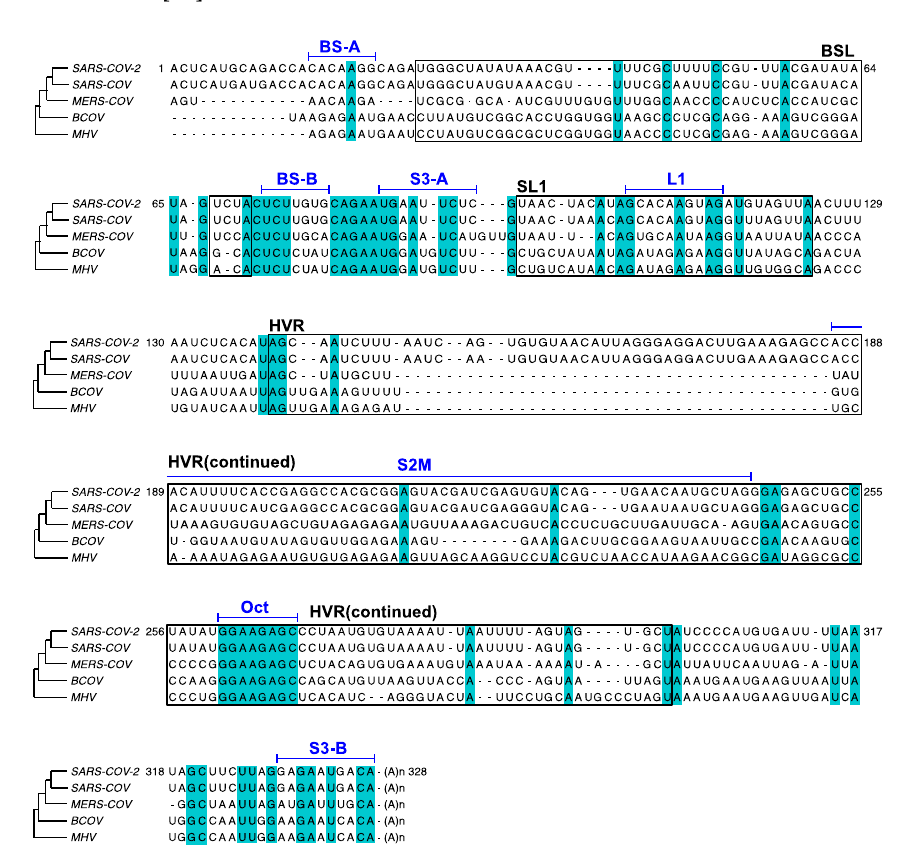
Figure 6. Comparison of the 3 ′ UTR sequences among SARS-CoV-2 (RefSeq NC_045512.2), SARS-CoV (RefSeq NC_004718), MERS-CoV (NC_019843), BCoV (U00735), and MHV (NC_048217). Major RNA elements, BSL, SL1, and HVR, are boxed and annotated in black. Shorter RNA segments are annotated in blue above a bar aligned with the sequences. Conserved nucleotides are shaded in cyan. 717 nucleotides at the 5 ′ of MERS 3 ′ UTR are omitted for clarity.